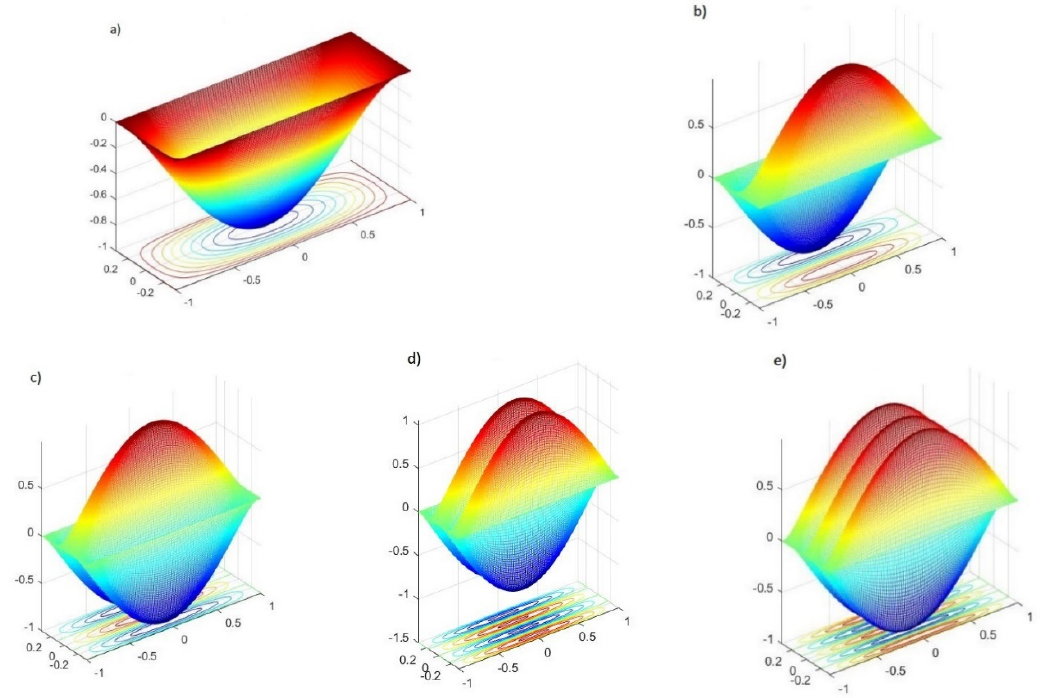
Figure 15. Vibrational modes for the SFG distribution without the agglomeration effect: ( a ) 1st mode, ( b ) 2nd mode, ( c ) 3rd mode, ( d ) 4th mode, ( e ) 5th mode.